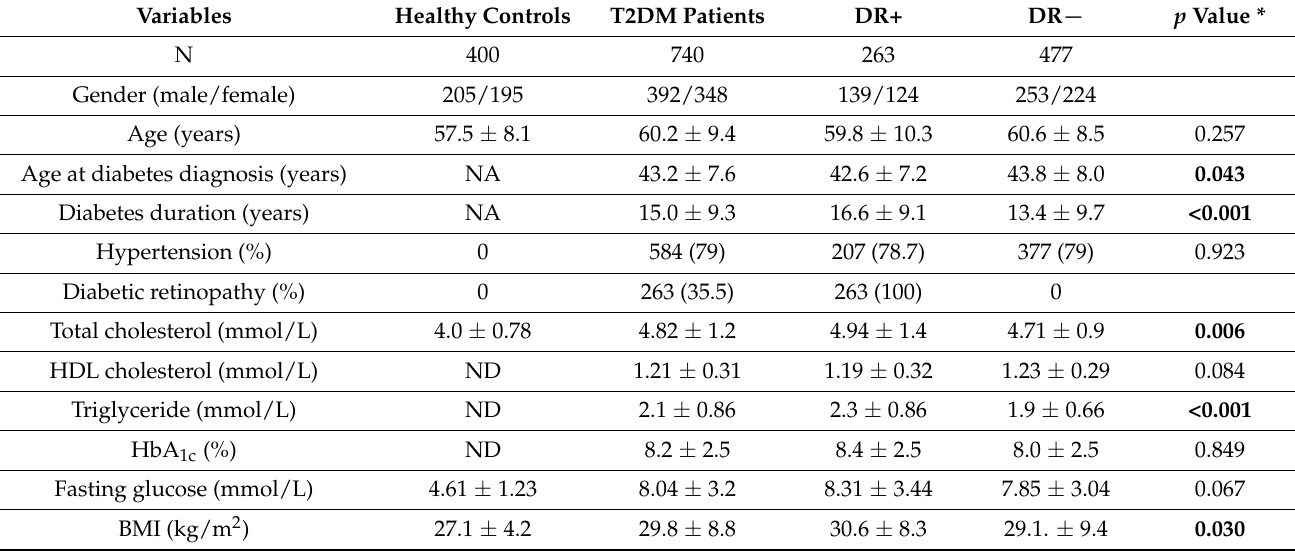
Table 1. Comparison of clinical and laboratory characteristics of T2DM patients with and without DR. Variables Healthy Controls T2DM Patients